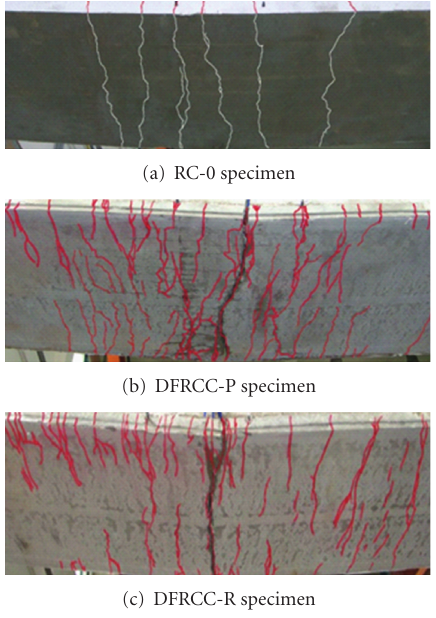
Figure 12: Crack pattern marked with ink pen at midspan